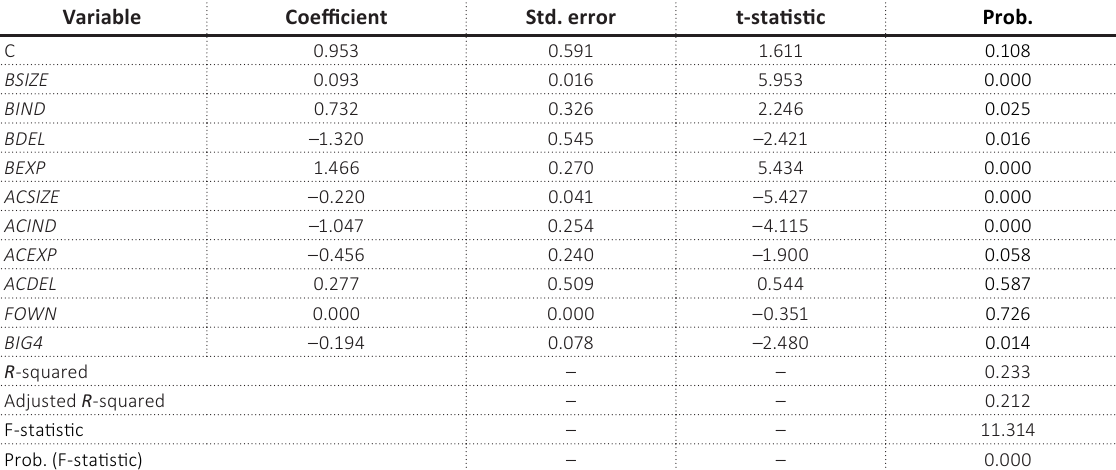
Table 2. OLS regression